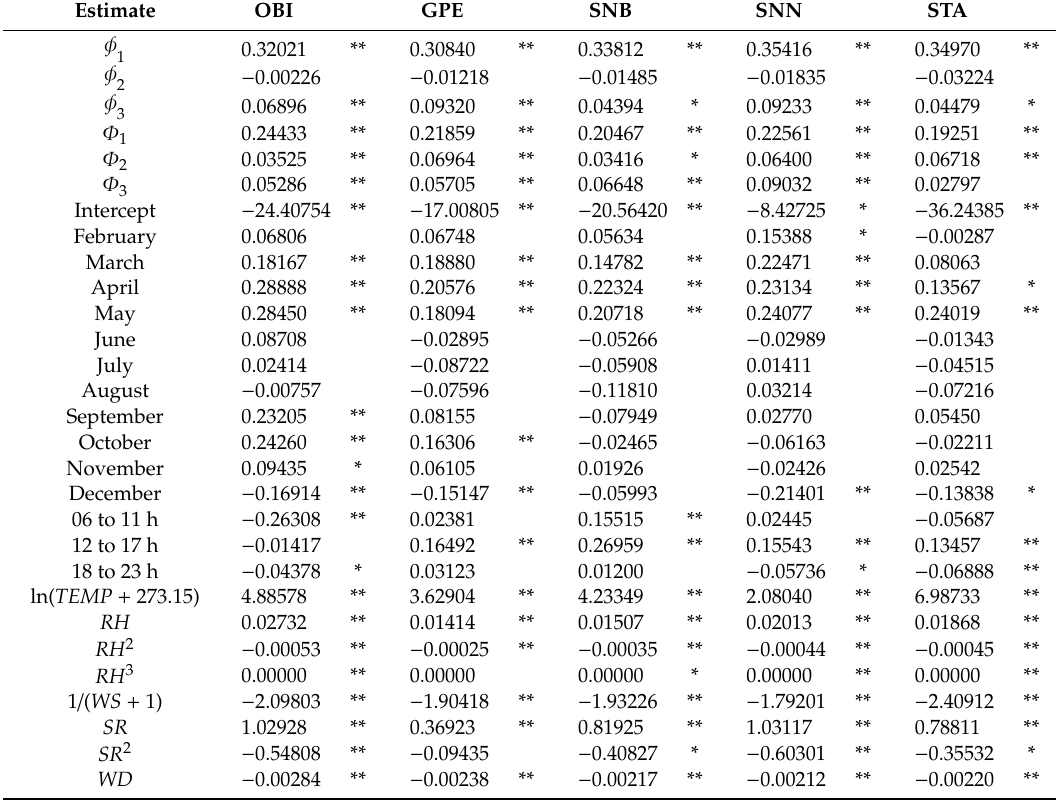
Table 9. ARMA and regression parameter estimates. Baseline (intercept) is overnight January average maximum O 3 concentrations. Figures with five zero decimals indicate smaller values. Significance levels: 0.05 (*), 0.01 (**).